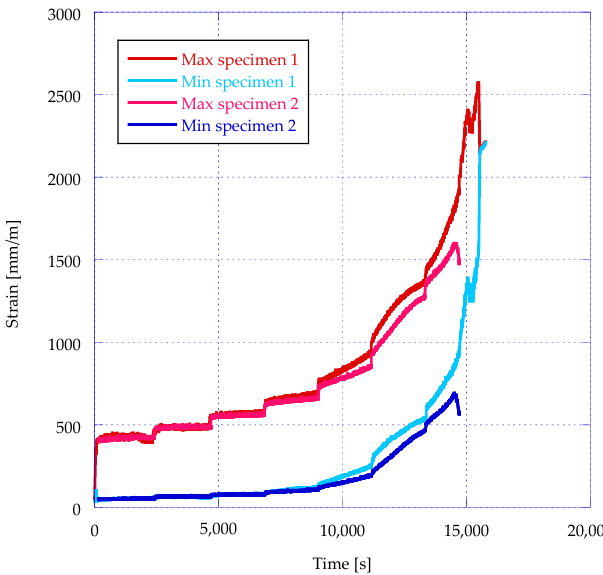
Figure 7. Evolution of the maximum and minimum strain for the SLC mix.